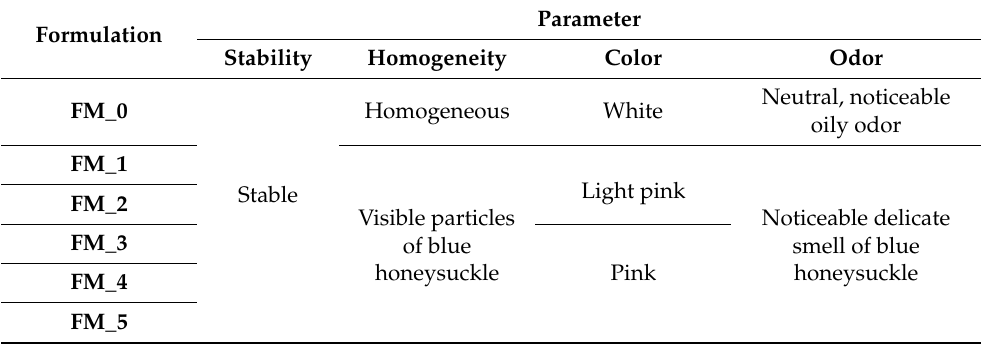
Table 2. Results of visual evaluation of cosmetic masks containing different concentrations of blue honeysuckle powder after stress and centrifuge